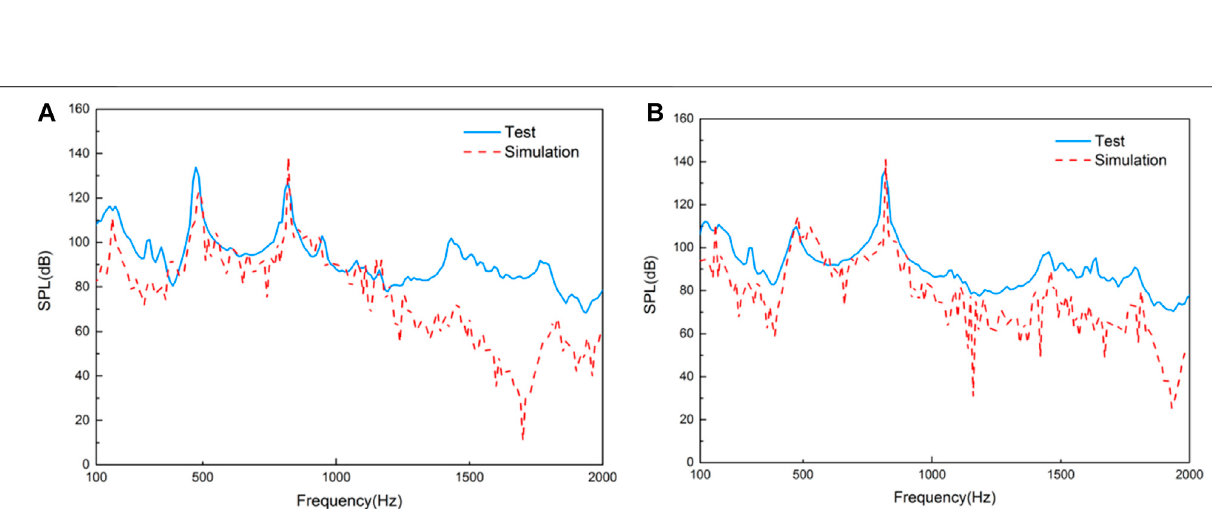
Frontiers in Materials |